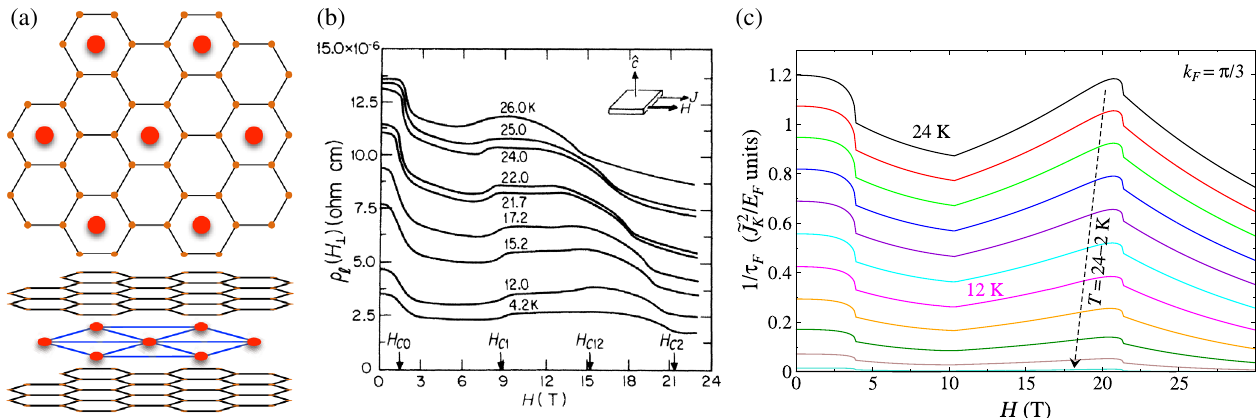
FIG. 1. (a) Schematics of EuC 6 . Small and large dots are C and Eu atoms, respectively. (b) EuC 6 in-plane resistivity data vs magnetic field, ρ ð H Þ , for various temperatures (see Ref. [18]). Arrows are the fields of the anomalies in ρ ð H Þ that correspond to transitions between magnetic states, extrapolated to T ¼ 0 . (Reprinted with permission from Ref. [18].) (c) Our representative results for the transport scattering